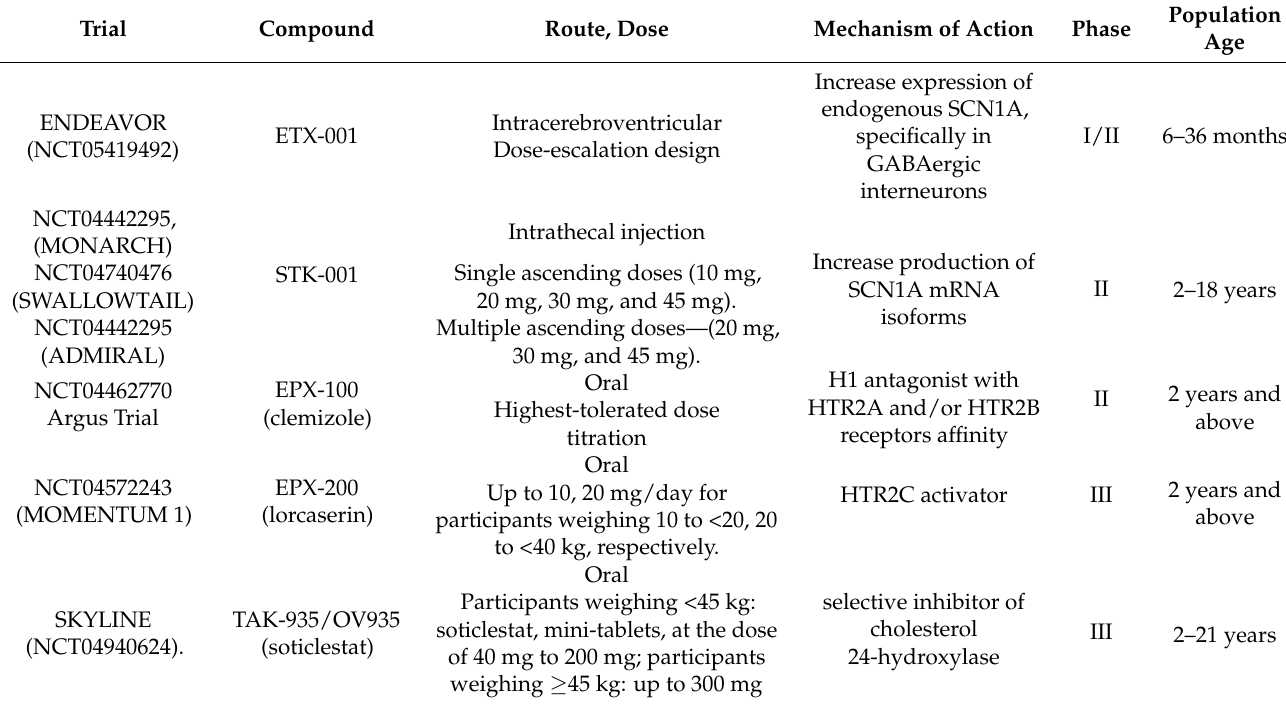
Table 2. Ongoing clinical trials of novel therapeutic agents in